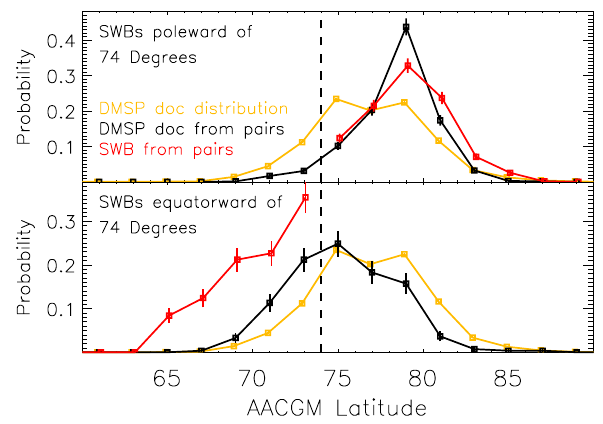
Fig. 3. Latitudinal probability distributions of boundary occurrence in the 12:00–18:00 MLT region. The red lines represent the latitude distributions of the SWBs that form matched pairs with DMSP doc boundary observations. Results from the Goose Bay and Finland SuperDARN radars have been combined. The black lines represent the latitude distributions of DMSP doc boundary observations from the same matched pairs. The yellow lines represent the latitude dis- tribution of all DMSP doc boundary observations made during the 5-year interval (1997–2001). The upper panel represents the re- sults from matched pairs where the SWBs are located poleward of 74 ◦ , whereas the lower panel represents the results from matched pairs where the SWBs are located equatorward of 74 ◦ . The vertical dashed line highlights the location of 74 ◦ AACGM